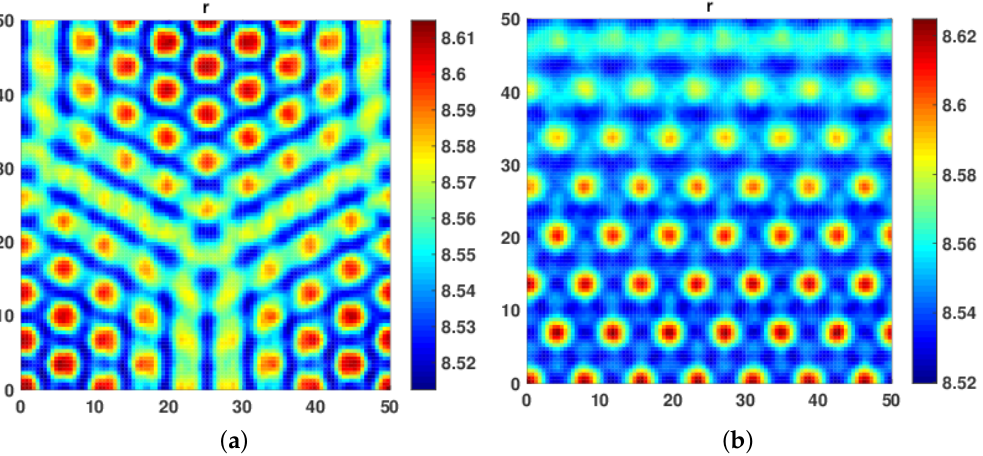
Figure 7. ( a ) A mixture of hot spot and labyrinth turing patterns obtained at d 3 = d 4 = 1.5. ( b ) A mixture of hot spot and labyrinth turing patterns obtained at d 3 = d 4 =